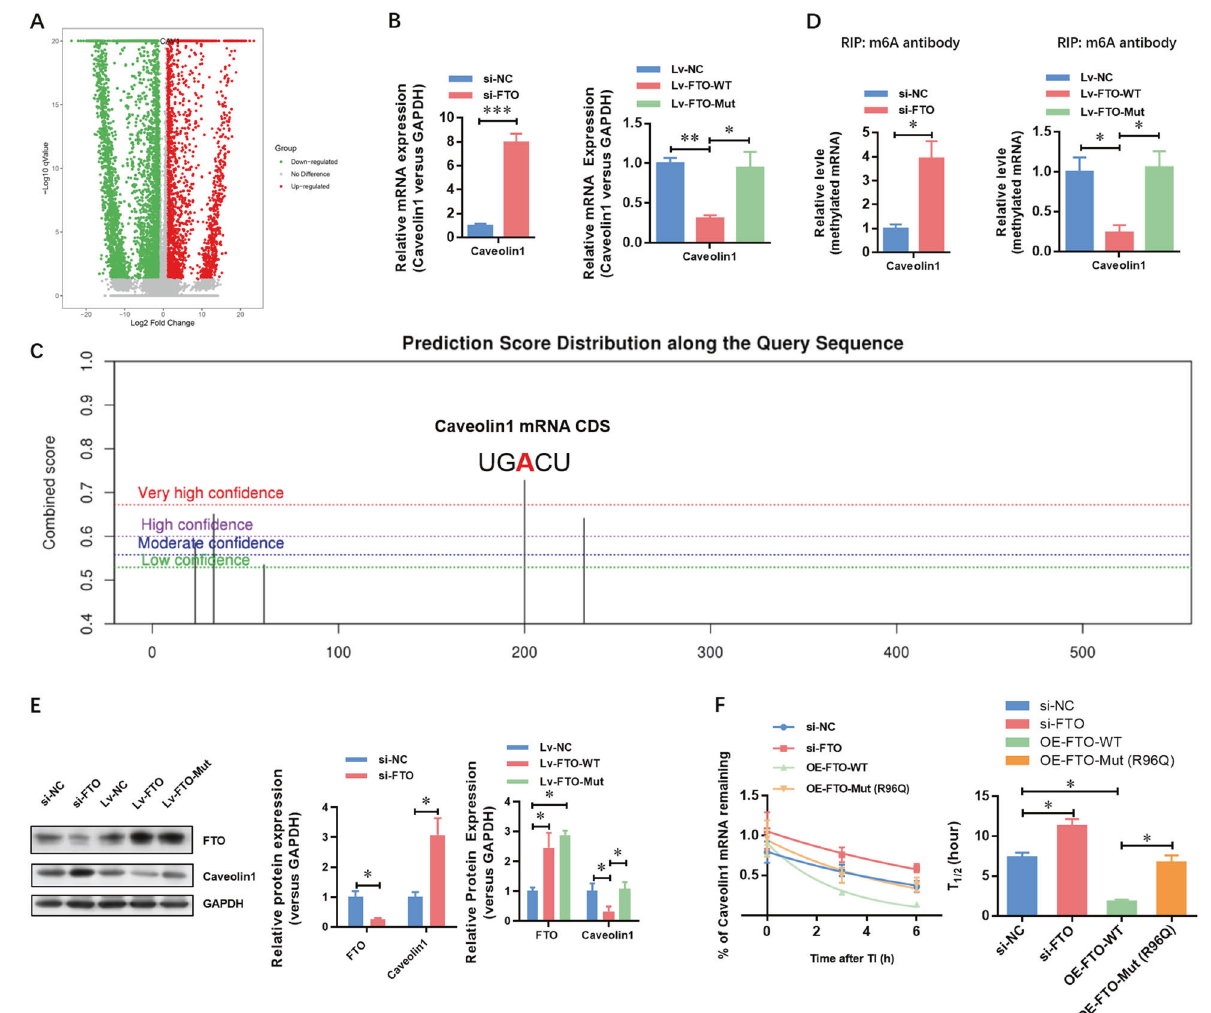
Fig. 4 Transcriptome-sequencing fi nds that FTO directly targets caveolin-1 mRNA and promotes its degradation. A Caveolin-1 was up- regulated upon FTO depletion as indicated in volcano plot. B The elevation of caveolin-1 mRNA in FTO-depleted AGS cells was veri fi ed by qRT- PCR. C The m 6 A modi fi cation site predictor SRAMP was used to predict the m 6 A modi fi cation site in the CDS region of caveolin-1. D The elevation of m 6 A methylated caveolin-1 mRNA in FTO-depleted AGS cells was veri fi ed by Me-RIP-qPCR. E The elevation of caveolin-1 mRNA in FTO-depleted AGS cells was veri fi ed by Western blotting analysis. F Transcription inhibition assay showed that FTO depletion dramatically attenuated the degradation rate of caveolin-1 mRNA. N = 3, * p < 0.05, ** p < 0.01 compared with the indicated